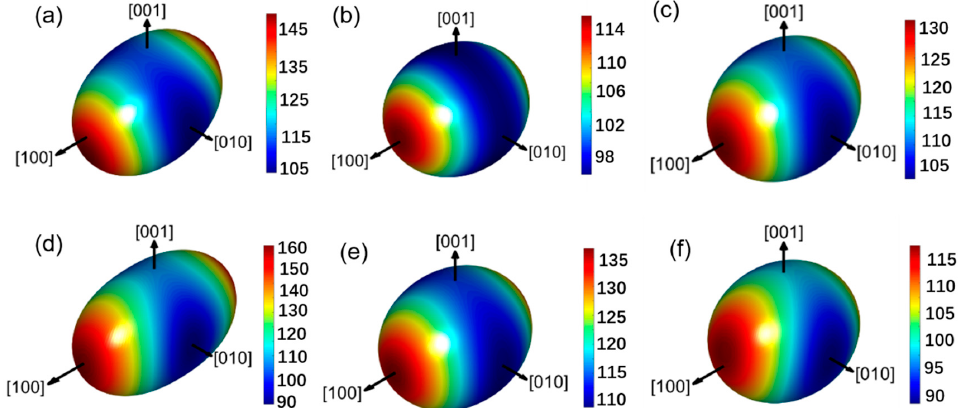
Figure 8. Bulk modulus 3D surface of Al 13 (Fe,M) 4 phases with different elements doping (unit: GPa).